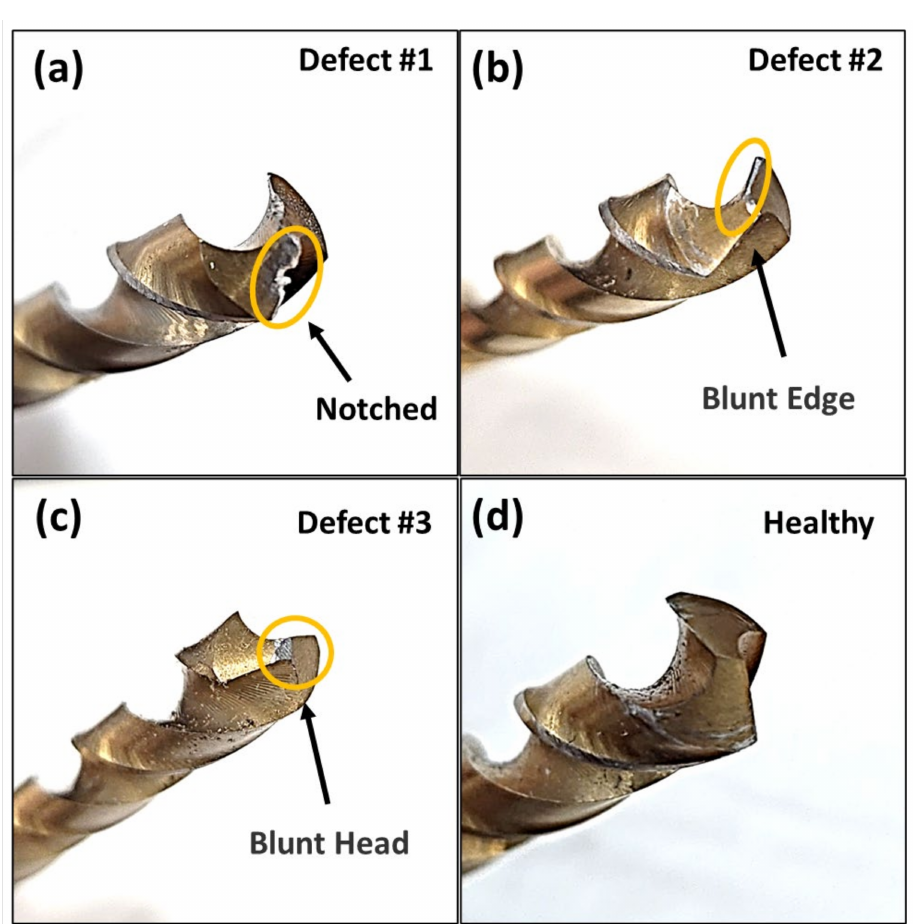
Figure 3. ( a ) An image of a notched drill bit, ( b ) an image of a blunt-edged drill bit, ( c ) an image of a blunt-headed drill bit, and ( d ) an image of a healthy dill bit without any